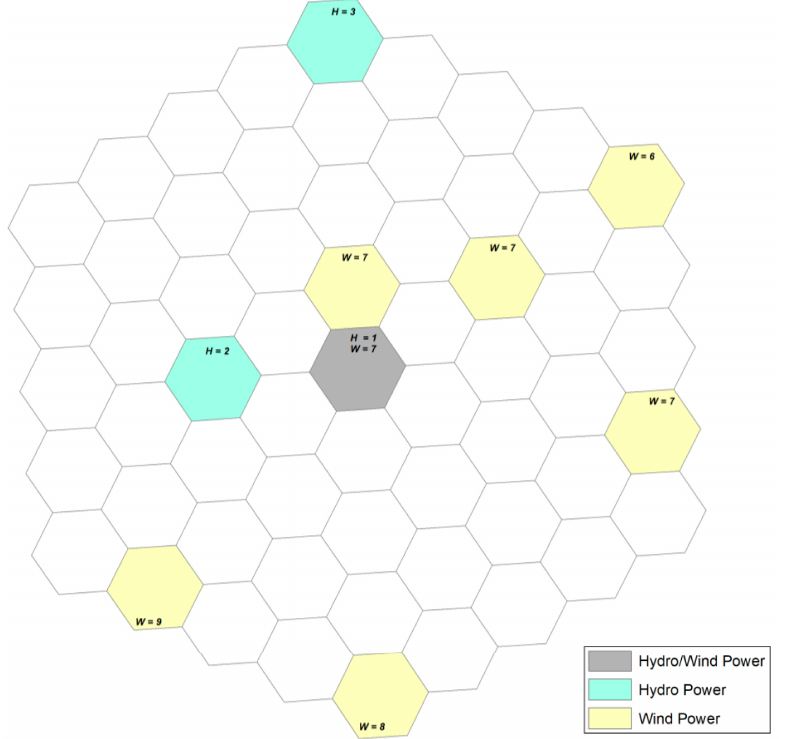
Figure 2. Hexagonal cell network with hypothetical distribution of hydroelectric power plants and wind farms. H and W indicate respectively the months of the year for which there is minimum energy availability for hydroelectric plants and wind farms.